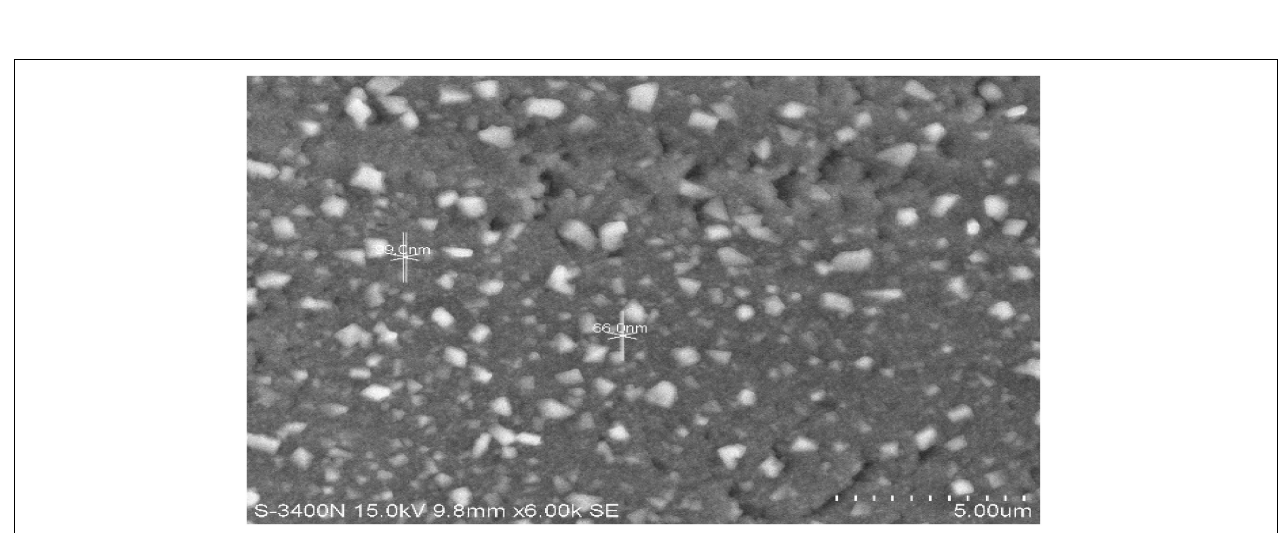
FIGURE 7 | Scanning electron microscopy (SEM) image of AgNPs of P. variotii.